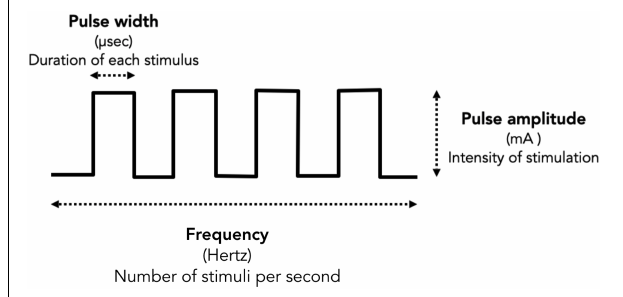
FIGURE 2 | Stimulation parameters. There are main three stimulation parameters determine for the size and intensity of each stimulus of an EMS including pulse amplitude, pulse width, and frequency. Pulse amplitude is the intensity of the stimulation, measured in milliampere (mA). Pulse width is the duration of each stimulus, measured in microseconds. Frequency is the number of stimuli delivered each second, measured in hertz